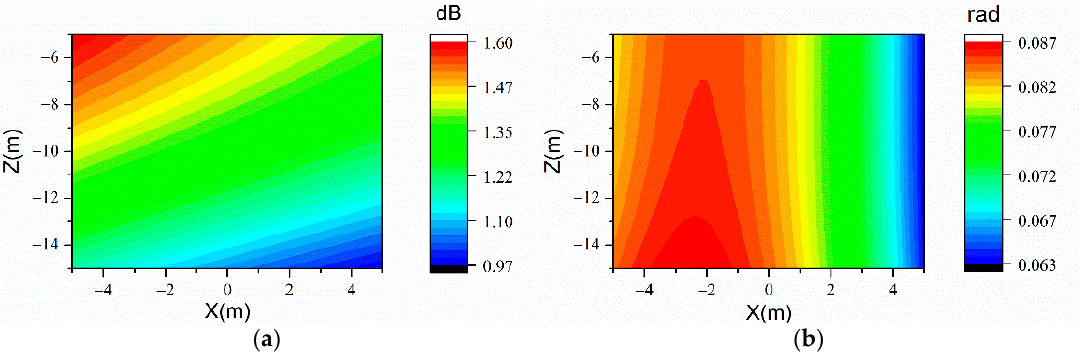
Figure 6 . The sound prediction errors of ESM on the prediction plane when ℎ (cid:3022) = 0.2 m at the Figure 6. The sound prediction errors of ESM on the prediction plane when h U = 0.2 m at the frequency of 71 Hz frequency of 71 Hz (234 uniform arranged measurement points determined by SVM). ( a ) 𝑝 (cid:3006) and ( b ) (234 uniform arranged measurement points determined by SVM). ( a ) p E and ( b ) ϕ E 𝜑 (cid:3006) .